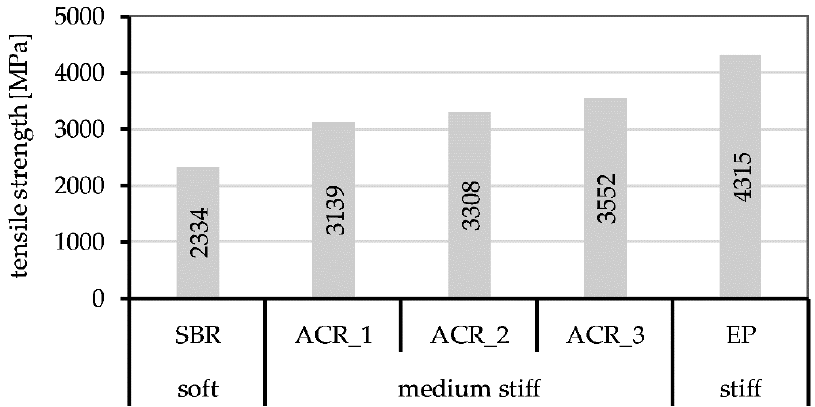
Figure 4. Tensile strengths of exemplary impregnated fiber strands made of carbon fibers (48 k strands); results adapted from [10,25]; stiffness quantitively described concerning the mechanical properties (compare Table 2).